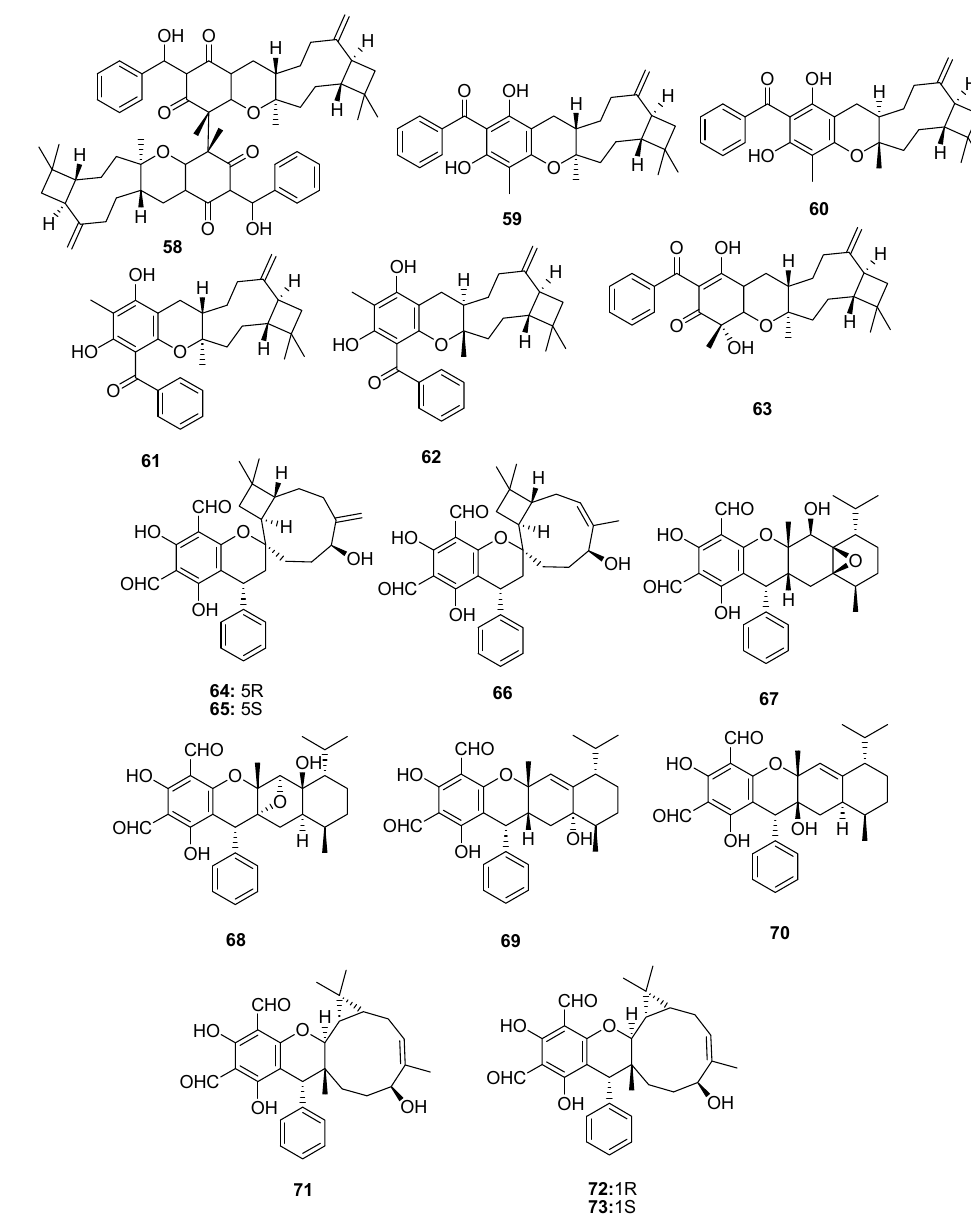
Figure 6. Meroterpenoids isolated from P. guajava L.